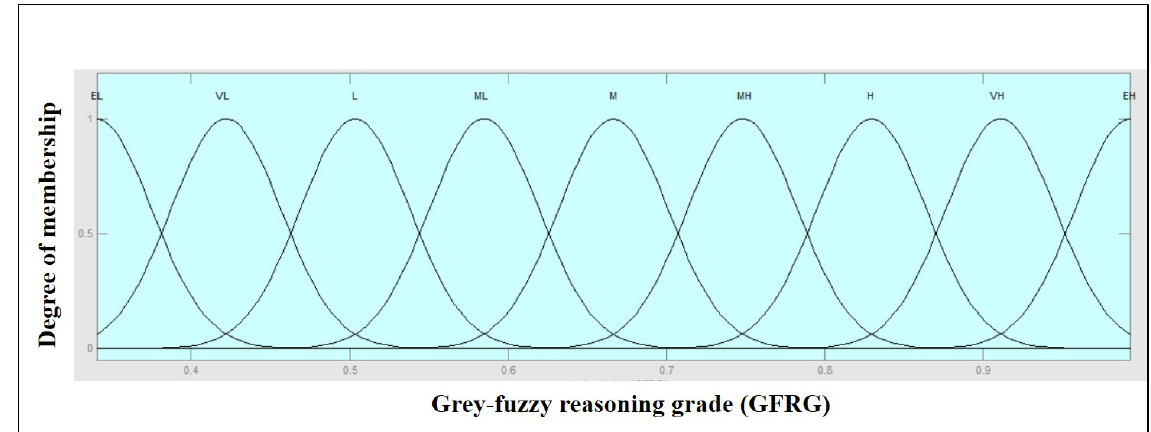
Figure 8. Output GFRG Gaussian function with extremely low (EL), very low (VL), low (L), medium low (ML), medium (M), medium high (MH), high (H), very high (VH), and extremely high (EH).